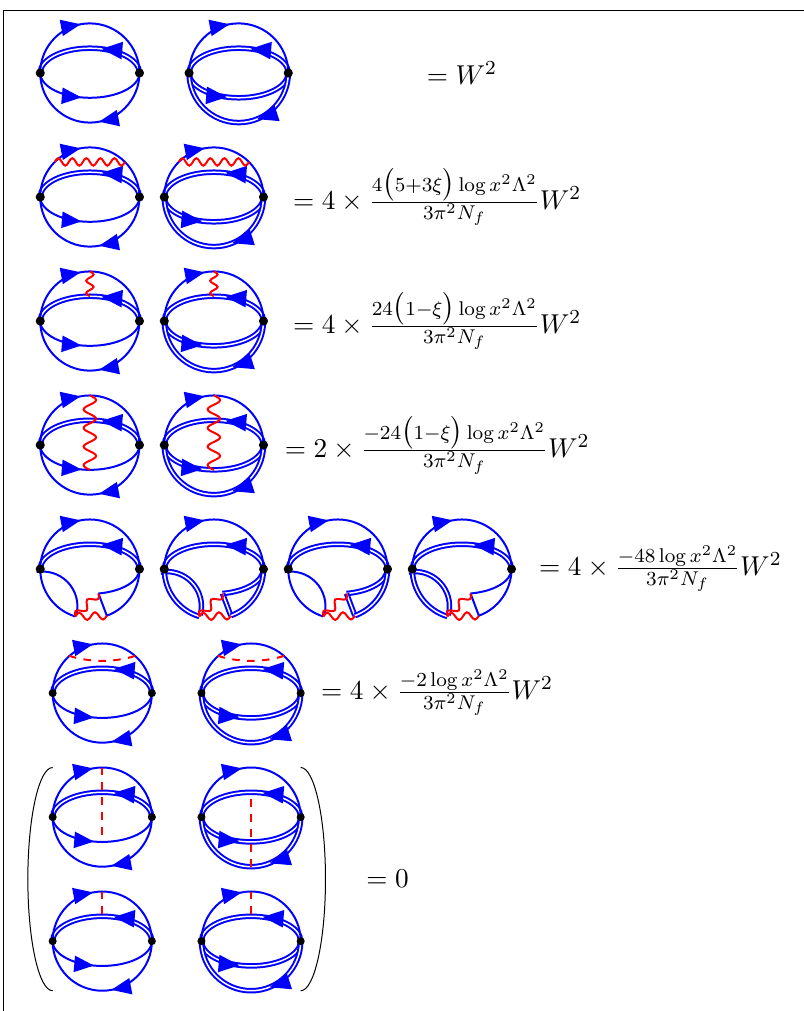
Table 7 . (bQED (cid:0) ) quartic bifundamental operator renormalization. Each graph has the (cid:13)avor index k running in its bottom